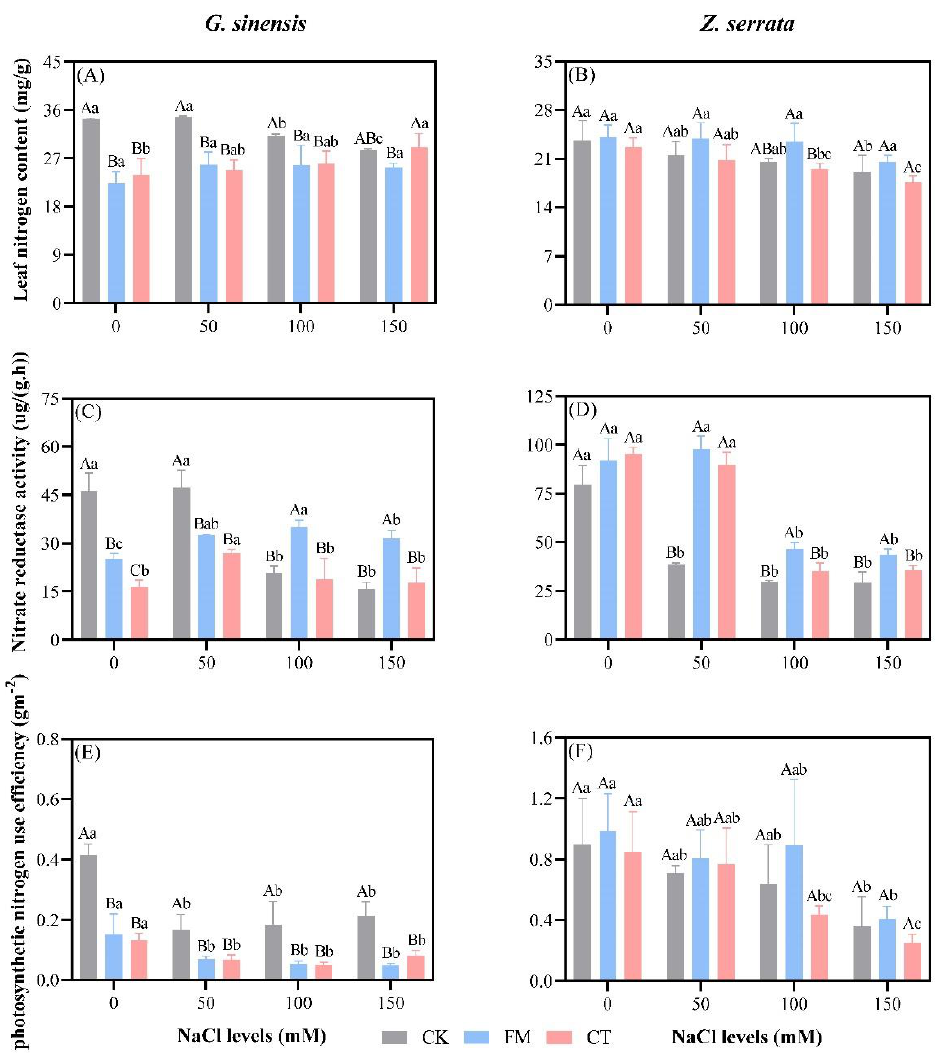
Figure 5. Variations in the leaf N content, nitrate reductase activity, and photosynthetic N-use efficiency between treatments. ( A ) leaf N content of G. sinensis different treatments; ( B ) leaf N content of Z. serrata different treatments; ( C ) nitrate reductase activity of G. sinensis different treatments; ( D ) nitrate reductase activity of Z. serrata different treatments; ( E ) photosynthetic N-use efficiency of G. sinensis different treatments; ( F ) photosynthetic N-use efficiency of Z. serrata different treatments. Uppercase letters indicate a significant difference between various inoculation treatments under the same salt levels ( p < 0.05). Lowercase letters indicate a significant difference between various salt concentrations under the inoculation treatments ( p <